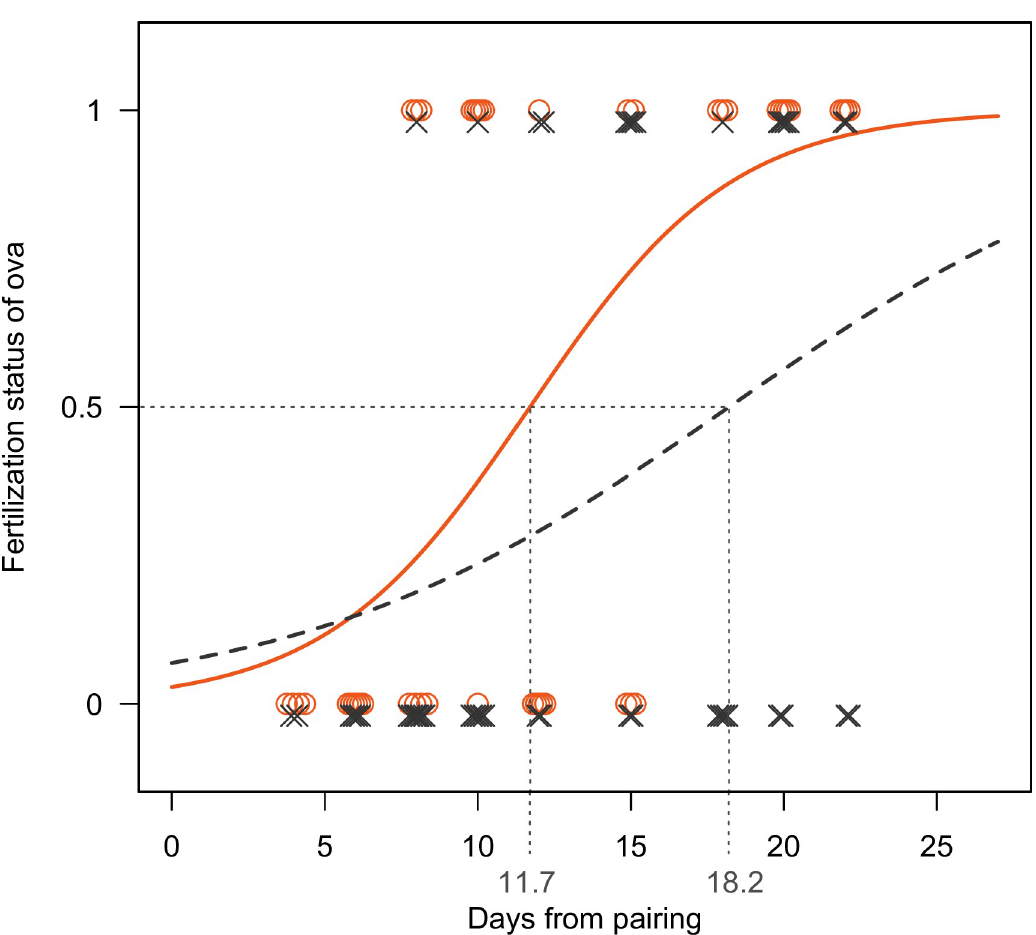
Fig 3. Male coloration and timing of fertilization. Circles indicate females that paired with colorful males and crosses indicate females that paired with drab males. Solid and dotted curves indicate logistic regression lines of females that paired with colorful and drab males,